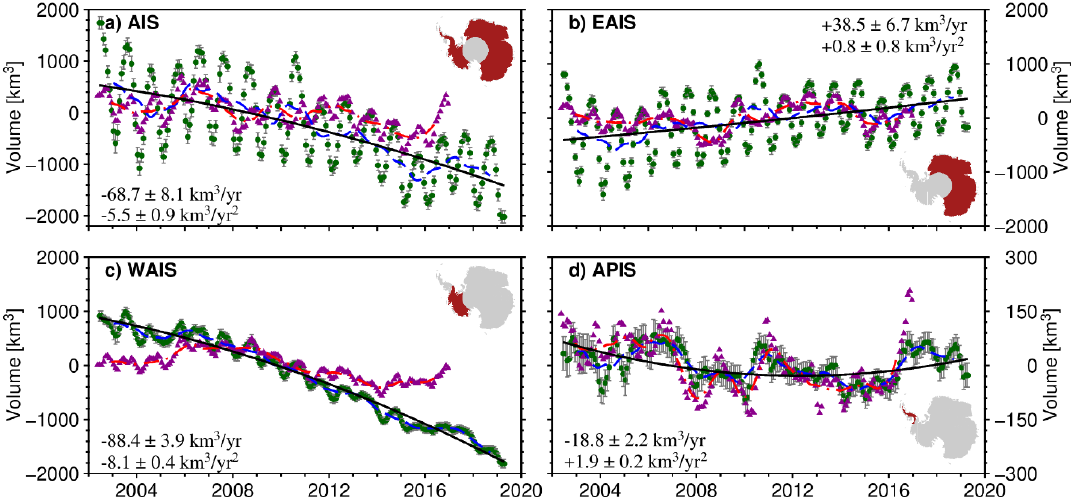
Figure 7. Volume changes in the AIS north of 81.5° S ( a ) and the three subregions (( b ): EAIS, ( c ): WAIS, and ( d ): APIS) from our combined altimetric time series (green dots) and IMAU-FDM (purple triangles). The blue dashed curves and red dash-dotted curves are the time series after removing seasonal oscillations using a 13-month moving average. Due to the defects of the moving average algorithm, the 6-month values at the beginning and end of the time series are not displayed. The solid black lines are the best-fit quadratic curves for the altimetric volume time series. Included are the altimetric volume time series linear and quadratic trend estimates. The gray error bars show the 1σ uncertainty range of the altimetry data. The regions covered by each localization are shaded red in the inset. The boundaries refer to the Antarctic drainage systems in [47] .